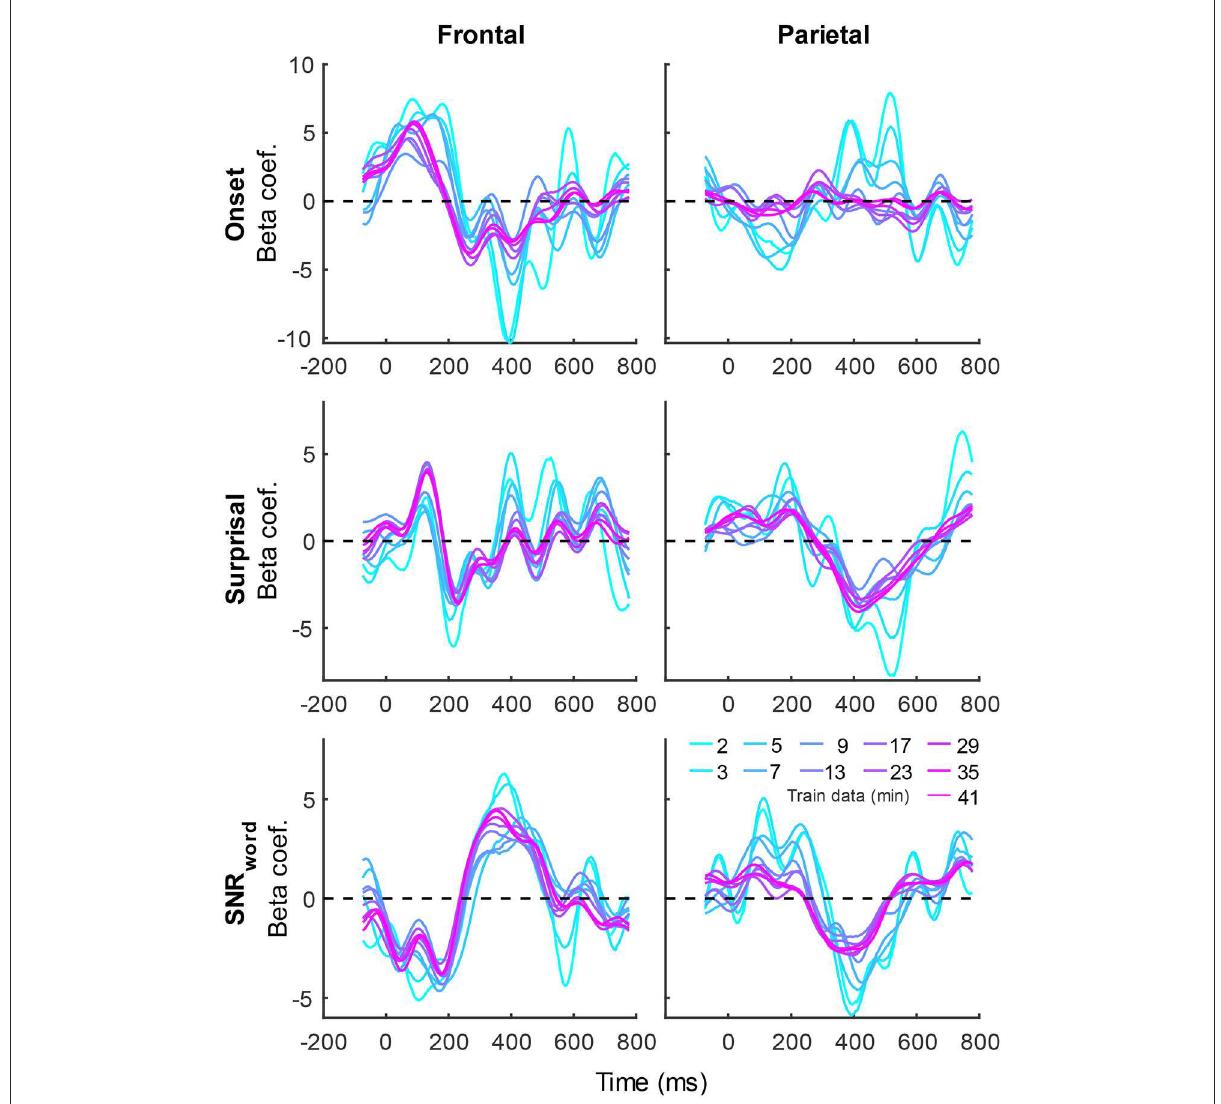
FIGURE5 Group-averaged TRF time courses of model beta coefficients for onset (top row) , surprisal (middle row) , and SNR word (bottom row) features from the sparser model in frontal (left column) and parietal (right column) ROIs, as a function of training data quantity (see legend in bottom right ). Note that these TRFs contain a broader range of latencies than those in Figure 3 due to these features engaging higher-order processing, reflected in key TRF features such as the N400 response seen in parietal ROI. See also heatmap depiction of the TRFs in Supplementary Figure 2 for easier comparison across different data quantities, and Supplementary Figure 4 for correlation matrices comparing TRF morphologies across different data